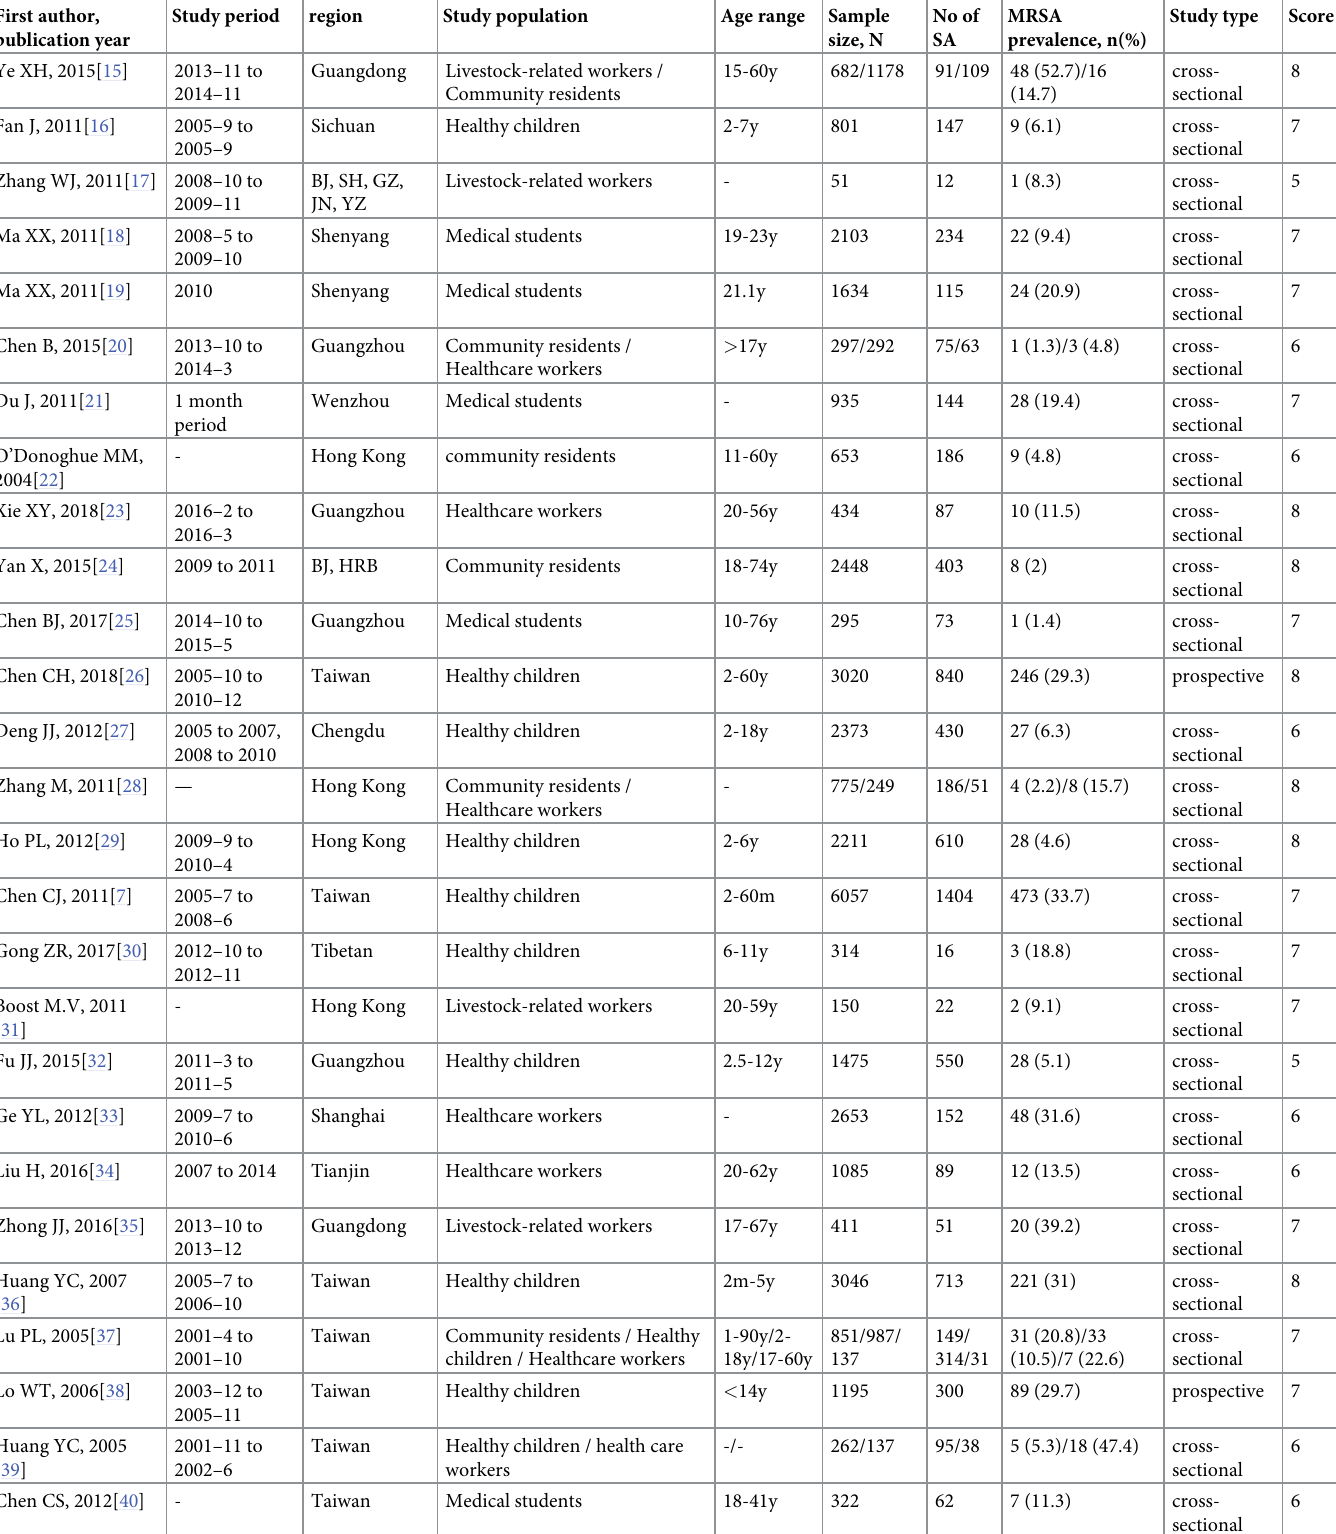
Table 1. Characteristics of all the included